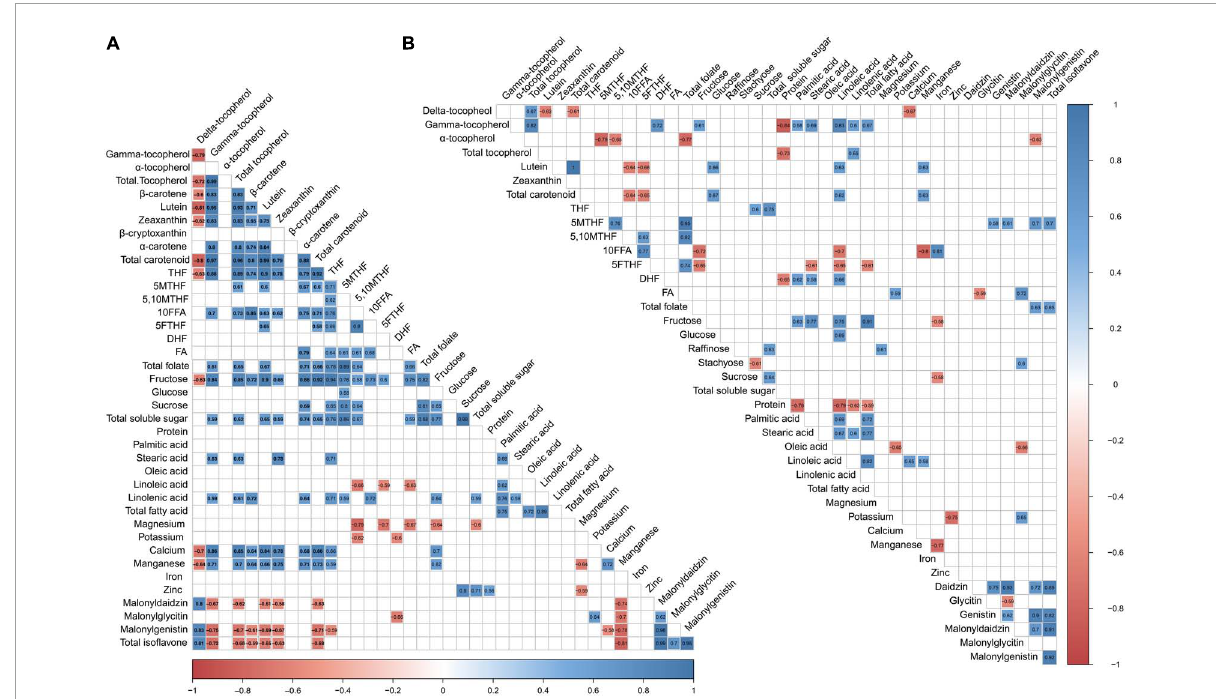
FIGURE5 Correlation analysis of quality traits at vegetable and mature stages. (A) Vegetable stage and (B) mature stage. Empty cells indicate no significant correlations between traits ( P >